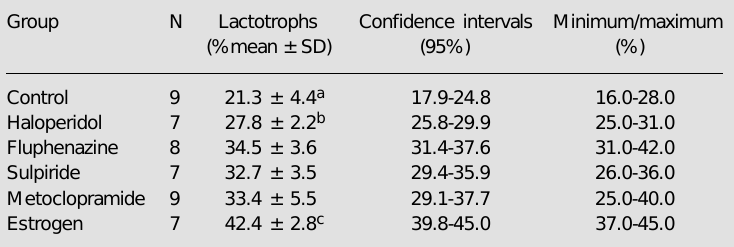
Table 2 - Percentage of immunoreactive lactotrophs in rat anterior pituitaries, in the absence of treatment and under estrogen or dopamine receptor antagonist treatment. a P<0.05 compared to the other groups (ANOVA). b P<0.05 compared to fluphenazine, sulpiride and metoclopramide (ANOVA). c P<0.05 compared to haloperidol, fluphena- zine, sulpiride and metoclopramide